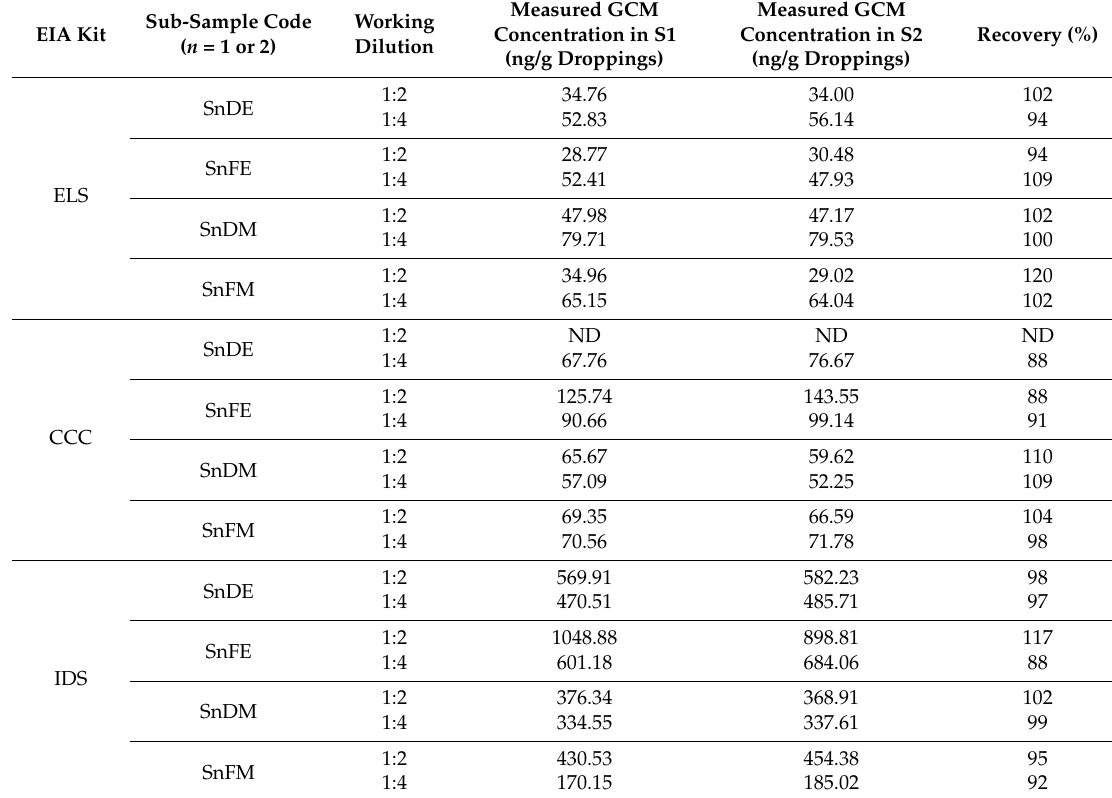
Table 6. Relative accuracy of GCM measurements under all tested